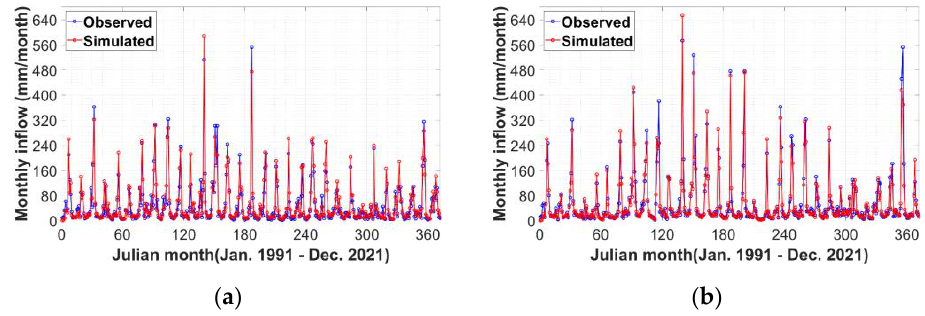
Figure 3. Monthly inflow simulation results: ( a ) Andong Dam Basin; ( b ) Hapcheon Dam Basin.